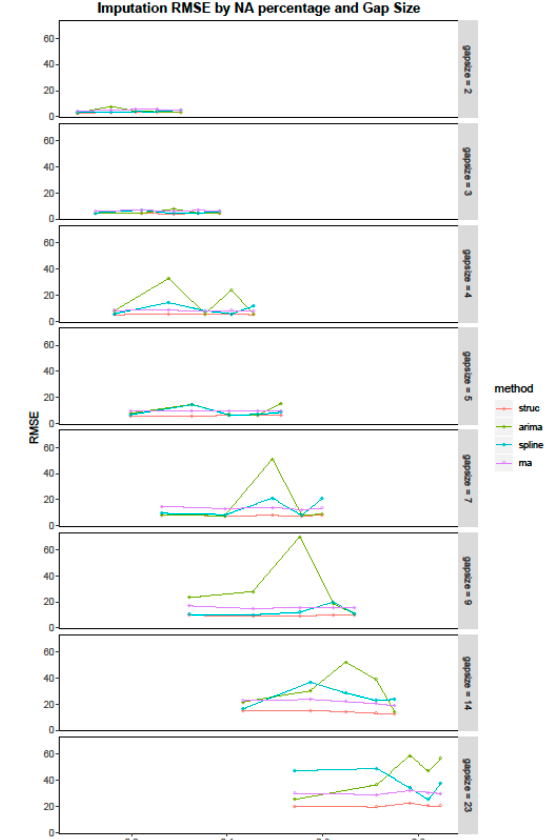
Table 2. Root mean square error (RMSE) for data imputation (lowest RMSE highlighted).